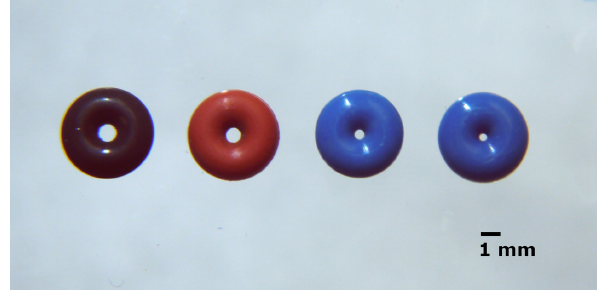
Figure 2. Photographs of pinch O-rings used during develop- ment of the CPI. The black and red O-rings (left) are the initially adopted commercially available O-rings of 0.8mm × 2 . 0mm (in- ner diameter × cross section), with a Shore hardness of 75 (FPM) and 70 (MVQ), respectively. The blue O-rings (right) with 0.5 and 0.4mm inner diameters were produced in the laboratory out of two- component silicone rubber with a Shore hardness of 50. The 0.5mm inner-diameter O-ring was chosen as the optimal solution for the flight altitude of up to 20km (minimum inlet pressure) and lens pressures used in the instruments of the research group. On the right-hand side a 1mm scale is shown.